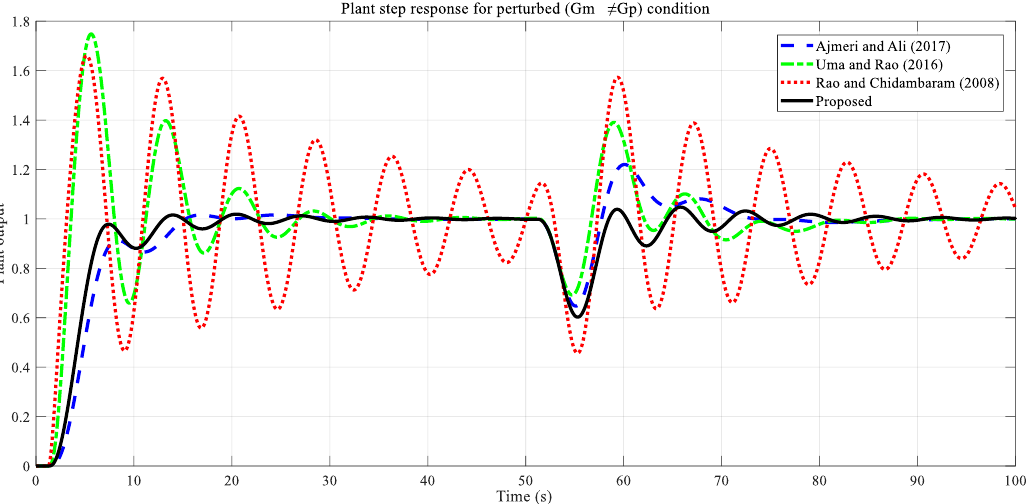
Figure 11. Performance comparison of the proposed methods and other methods, in terms of parameter changes, for Example 2 [15,16,18]. Table 5. IAE performance measures for Example